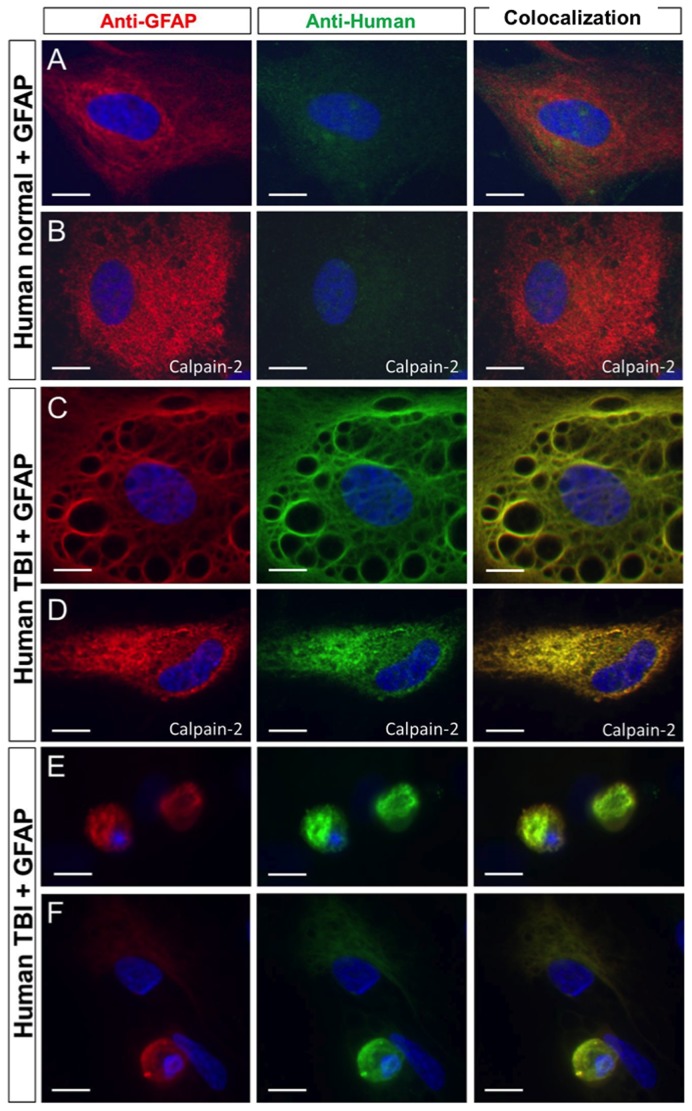
TBI autoantibodies colocalized with GFAP in primary rat astrocytes.Single confocal images (A–E) and flattened z-stacks (F) are shown of astrocytes stained with anti-GFAP antibody (red), human pooled TBI sera (green, Day 9–10, n = 3) or human normal control serum (green). Nuclei are blue. A. GFAP antibody stained GFAP fibrils in primary rat astrocytes (left), while human control serum showed diffuse green minor staining (middle) not colocalizing with GFAP (right). B. Astrocytes digested with calpain-2 after fixation labeled with GFAP (left) but not normal human serum (middle) as in A. C. Immunostaining by GFAP antibody (left) and human TBI sera (middle) strongly colocalized, as evidenced by yellow color (right). D. After calpain digestion, staining by the GFAP antibody (left) and human TBI sera (middle) colocalized (right) as in C, without changes in signal intensities. E. GFAP antibody (left) and human TBI sera (middle) brightly co-stained (right) rounded cells with condensed nuclear material. F. Flattened z-stacks of multiple confocal images are shown, to illustrate the greater staining intensities of GFAP (left) and TBI sera (middle) in a rounded cell compared to healthy cells. Exposure times were shorter in E, F compared to A–D. Scale bars 10 microns.